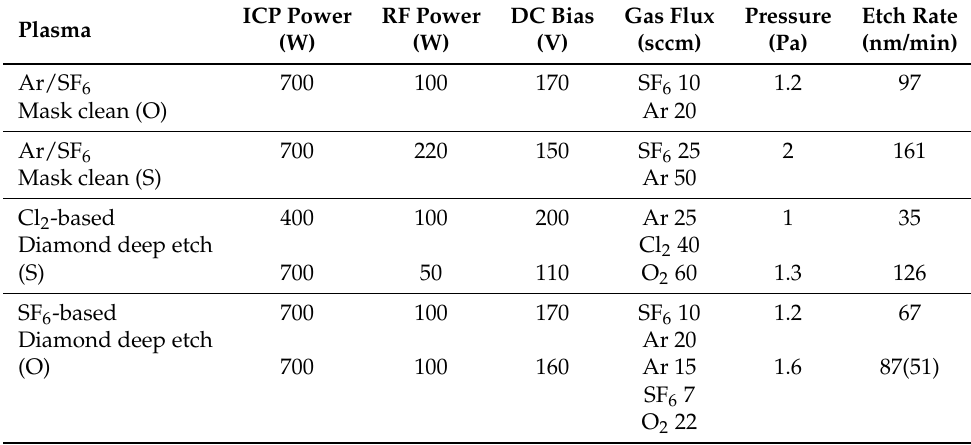
Table 1. Plasma recipes used in this work. Ar/SF 6 cleaning removes deposit from laser cutting from the quartz masks. The recipes used in the Sentech reactor in Basel, marked with (S), and the Oxford reactor in Saarbrücken, marked with (O), slightly differ but lead to comparable results. We note that the Cl 2 -based recipe is run on a ceramic based carrier system, while the SF 6 -based deep etch is run on standard silicon carrier wafers. Anode temperature is set to 20 ◦ C. For the SF 6 -based deep etch, the etch rate in parenthesis gives the rate at which the Ar/SF 6 /O 2 erode the quartz mask. ICP Power RF Power DC Plasma